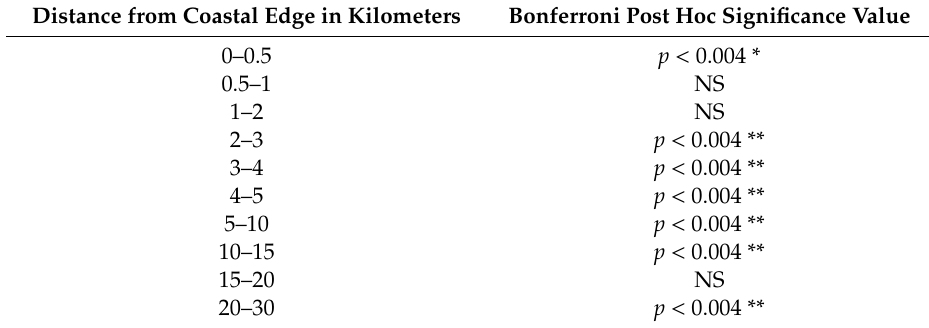
Table 2. Results of chi-square analyses for rare plants per area meters from the coastal edge 1 . Bonferroni post hoc significance values are listed for each category. p values with one asterisk (*) indicate that the number of rare species observations was significantly higher than expected (assuming random distribution across the reserve) and p values with two asterisks (**) indicate that the number of rare plant occurrences was significantly lower than expected. NS indicates insignificant results.